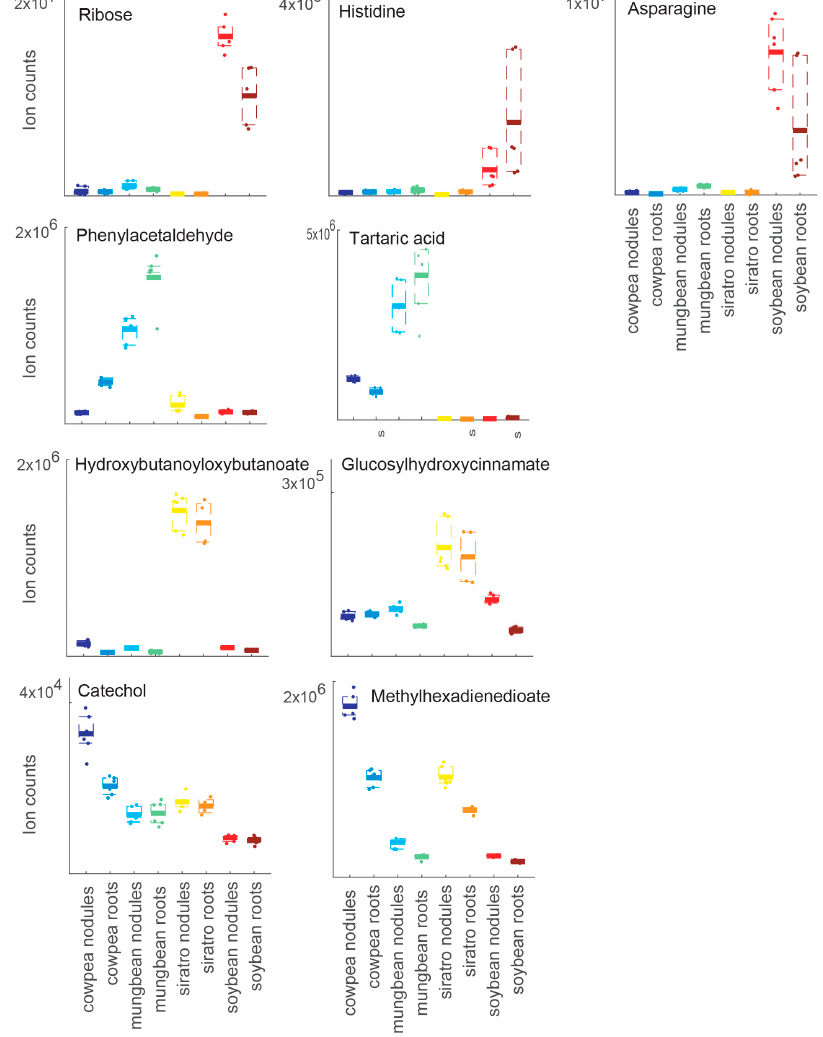
Figure 2. Ion counts of host-specific metabolic markers such as sucrose, asparagine, pentose (ribose) and histidine for soybean, tartaric acid and phenylacetaldehyde for mungbean, hydroxybutanoyloxybutanoate and glucosylhydroxycinnamate for siratro, and methylhexadienedioate and catechol for cowpea nodules and roots. Three biological replicates were examined, each analyzed twice by non-targeted metabolomics.